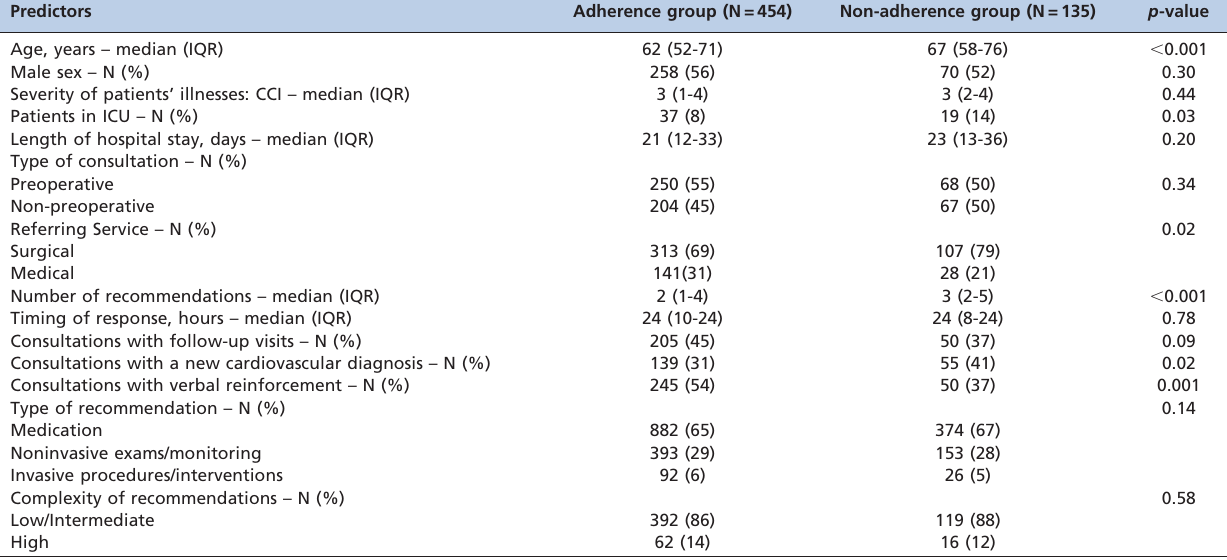
Table 2 - Bivariate analysis of individual predictors and adherence to recommendations. Predictors